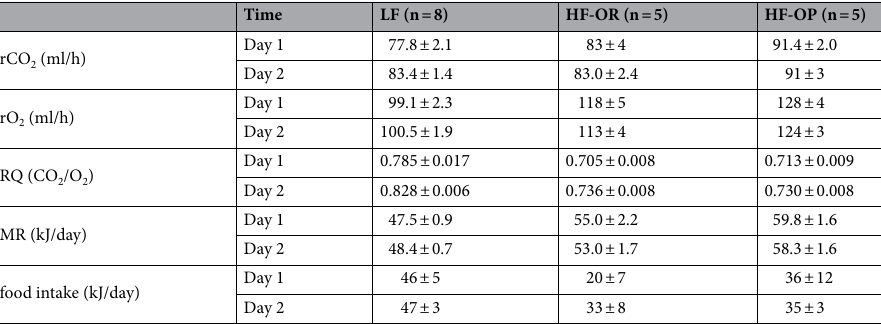
Table 4. Indirect calorimetry (IC) measurement results for 2 days, expressed as mean ± standard error (SE). Day 1 means the first 24 h in the IC box after the initial samples taken, and Day 2 is the second 24 h. rCO 2 and rO 2 are the CO 2 production and O 2 consumption in ml per hour, RQ is the respiratory quotient. The metabolic rates (MR) are calculated based on Ref. 38 . The lowest rows give the mean food intake (kJ) ± SE for the three